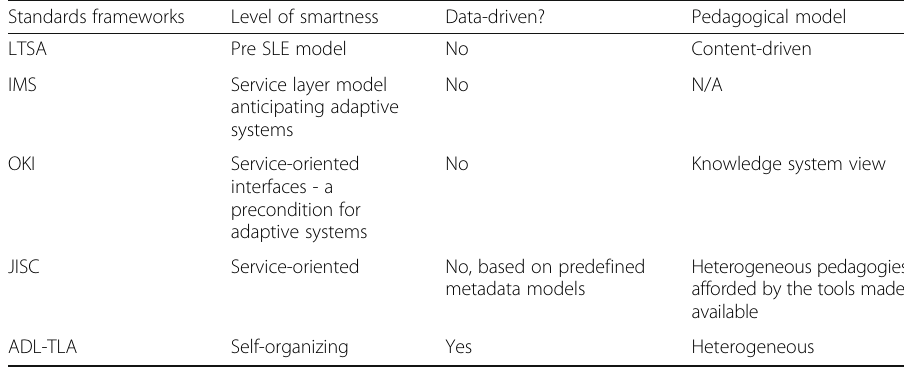
Table 2 How development of standard frameworks is positioned in relation to